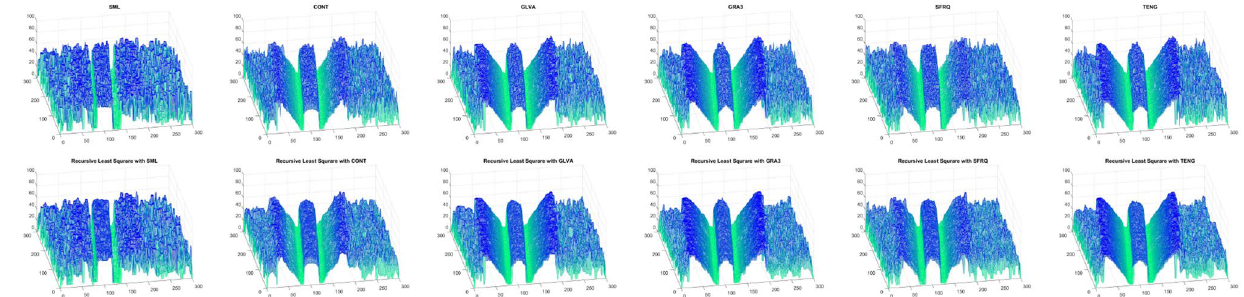
Figure 16. Shape reconstruction of Groove using FM with proposed RLS method. (left to right), SML, CONT, GLVA, GRA3,SFRQ, TENG. (top row) with FM only and (bottom row) using FM with RLS method.